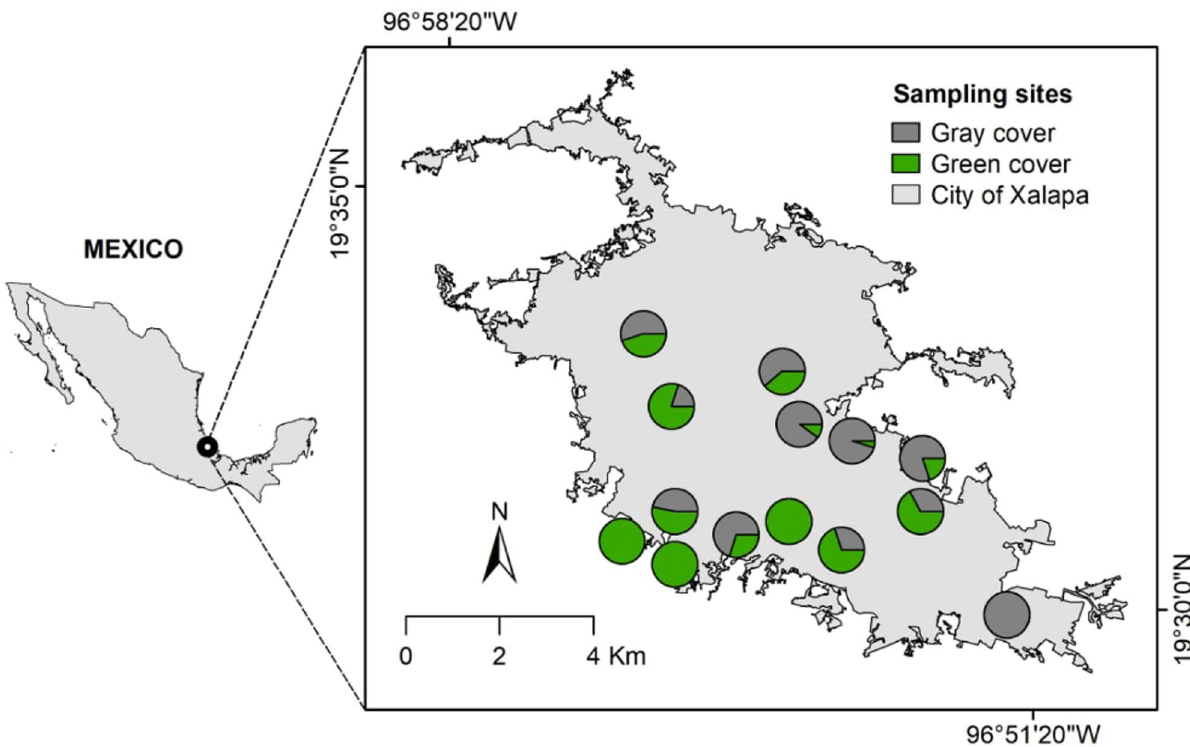
Figure 1. Map of the study site depicting the 14 sampling points that comprise a built cover gradient (from 0 to 100%) in the city of Xalapa, Veracruz, Mexico. The map was drawn in QGIS version 3.16 (https ://www.qgis.org) and edited in Inkscape version 0.92 (http://www.inksc